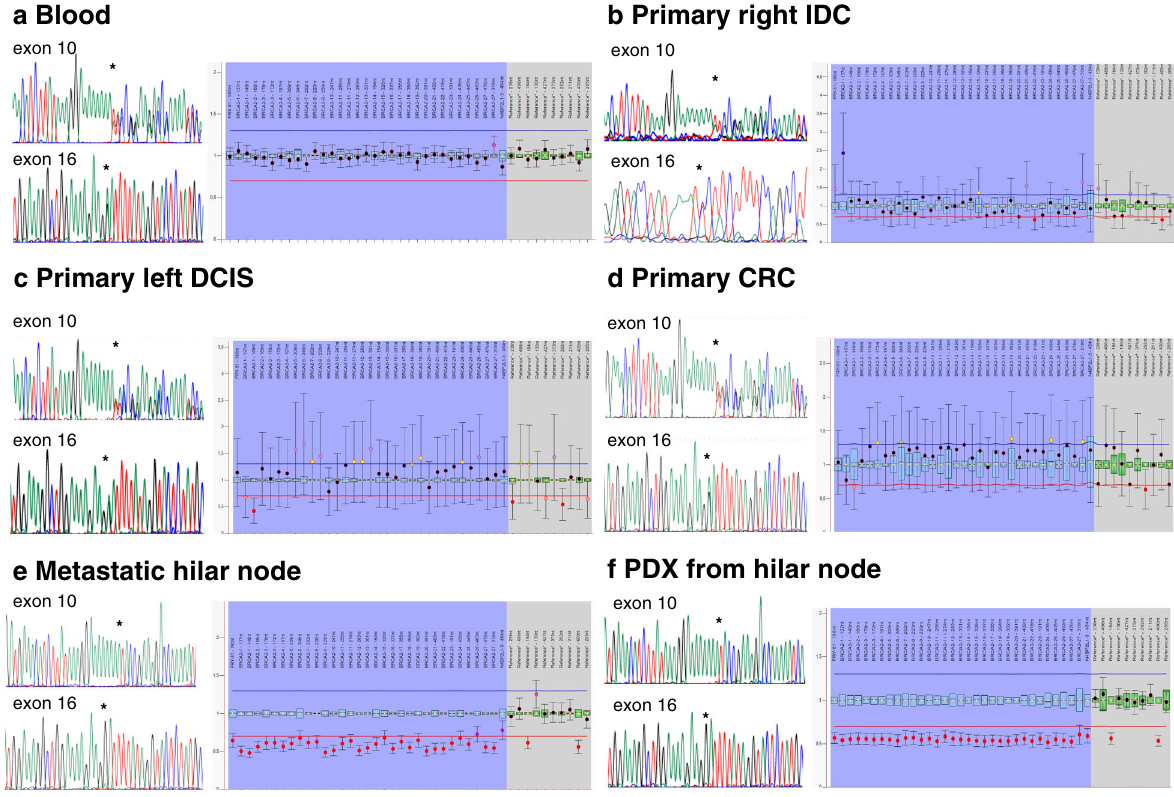
Fig. 3 Sanger sequencing and MLPA results from normal and tumor samples indicate that the c.1813dup and c.7796 A > G BRCA2 variants are in trans . Sanger electropherograms for both variants c.1813dup (exon 10) and c.7796 A > G (exon 16) show forward sequences, except for the invasive ductal carcinoma sample (IDC) ( b ) exon 16. MLPA results show the allelic dosage in a ratio chart format as displayed by Coffalyser.Net software. Probe ratios between 0.7 and 1.3 (blue and red lines) showed the presence of two BRCA2 alleles for blood ( a ), primary IDC ( b ), primary ductal carcinoma in situ (DCIS) ( c ), and primary colorectal cancer (CRC) ( d ). However, probe ratios for metastatic tumors ( e ) and their corresponding PDX (f ) were around 0.5, suggesting the presence of only one BRCA2 allele. All Sanger sequences are consistent with their corresponding MLPA fi ndings, i.e. presence of heterozygote variants in Sanger matches with the presence of two allele MLPA evidence while the monoallelic presence of a variant matches with one allele from MLPA outcome. MLPA and Sanger sequences for the skin biopsy and the other metastatic and PDXs samples are shown in Figure S1. *indicates the variant